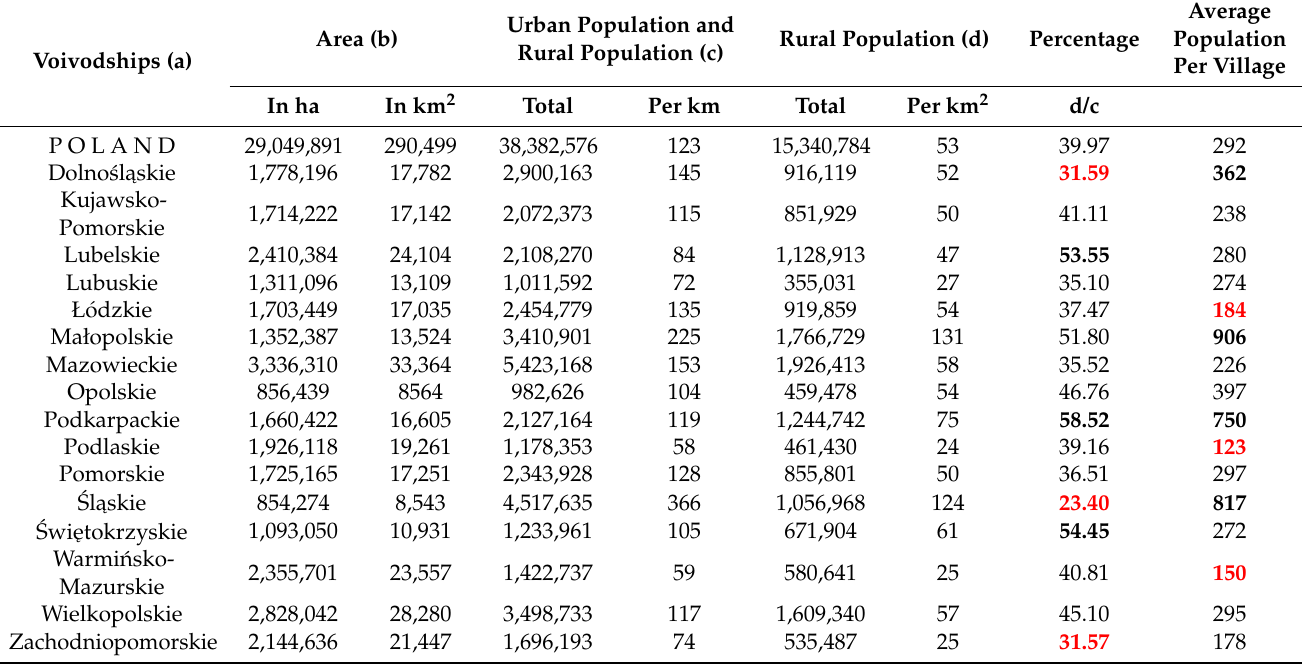
Table 14 presents the demographic development in Poland by voivodship (NUTS 2), accounting for population density per km 2 and average population of one village. Table 14. Poland’s population in 2020 by place of residence